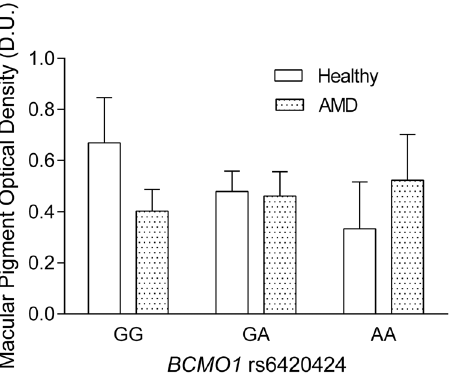
Figure 2. MPOD as a function of BCMO1 rs6420424 (error bars indicate + SD). Healthy participants with the GG genotype show on average significantly higher MPOD compared to those with the AA genotype. There were no significant differences between genotypes in the AMD group.